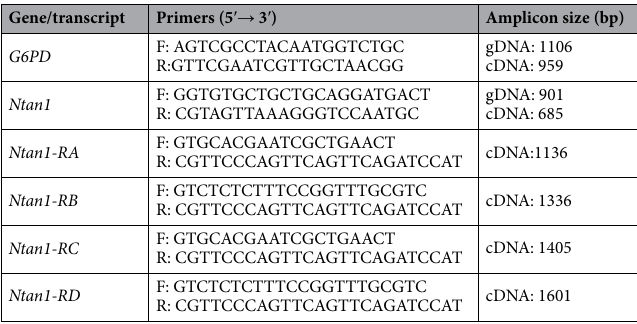
Table 4. Primers designed for the RT-PCR gene expression analysis of G6PD , Ntan1 and Ntan1 transcripts. The corresponding amplicon size for each primer pair is also